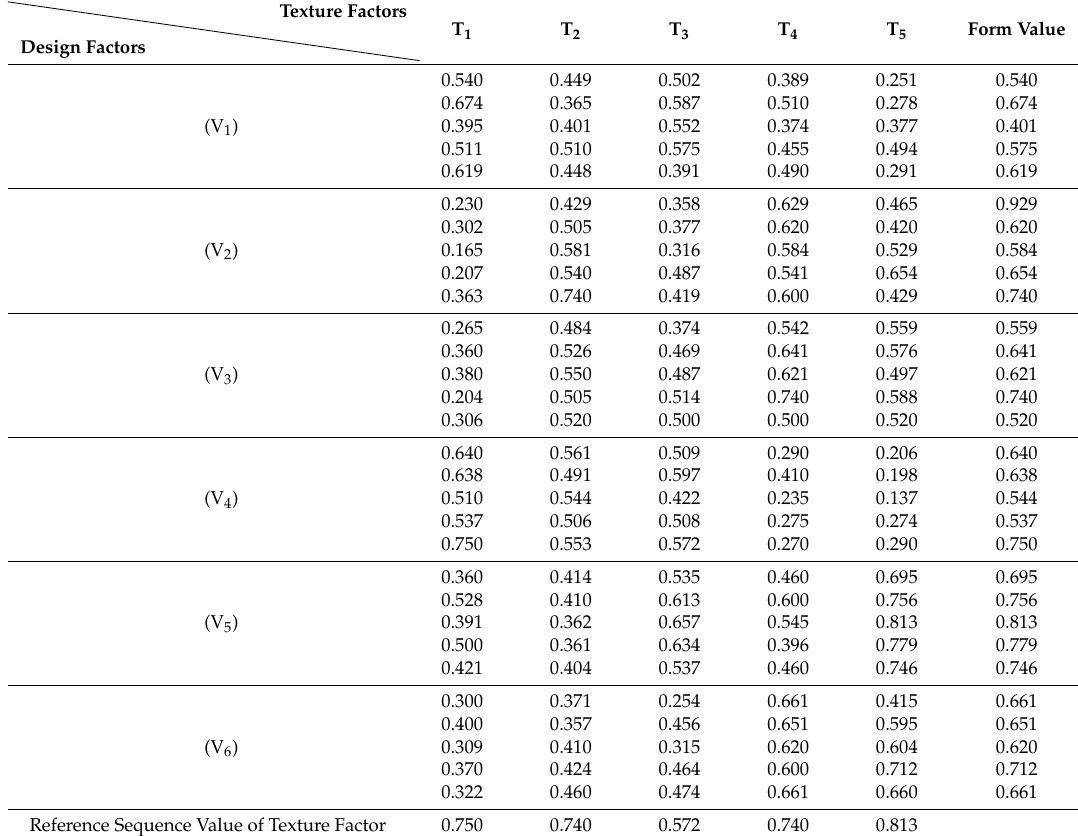
Table 1. The setting of grey correlation reference sequence of the digitals.